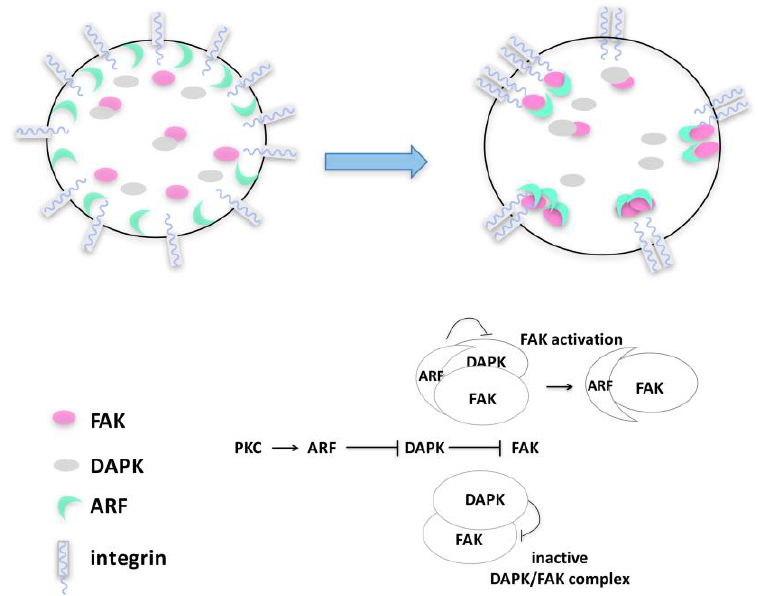
Figure 4. p14ARF–FAK cross-talk upon cytoskeleton remodeling. Upon PKC activation during the initial steps of cell spreading, p14ARF protein accumulates in the cytoplasm and is recruited at focal adhesions where it interacts with FAK, inducing its accumulation. Upon substrate adhesion, a p14ARF/FAK/DAPK protein complex is detected in the cytoplasm, in which ARF induces FAK stabilization, protecting it from DAPK degradation.